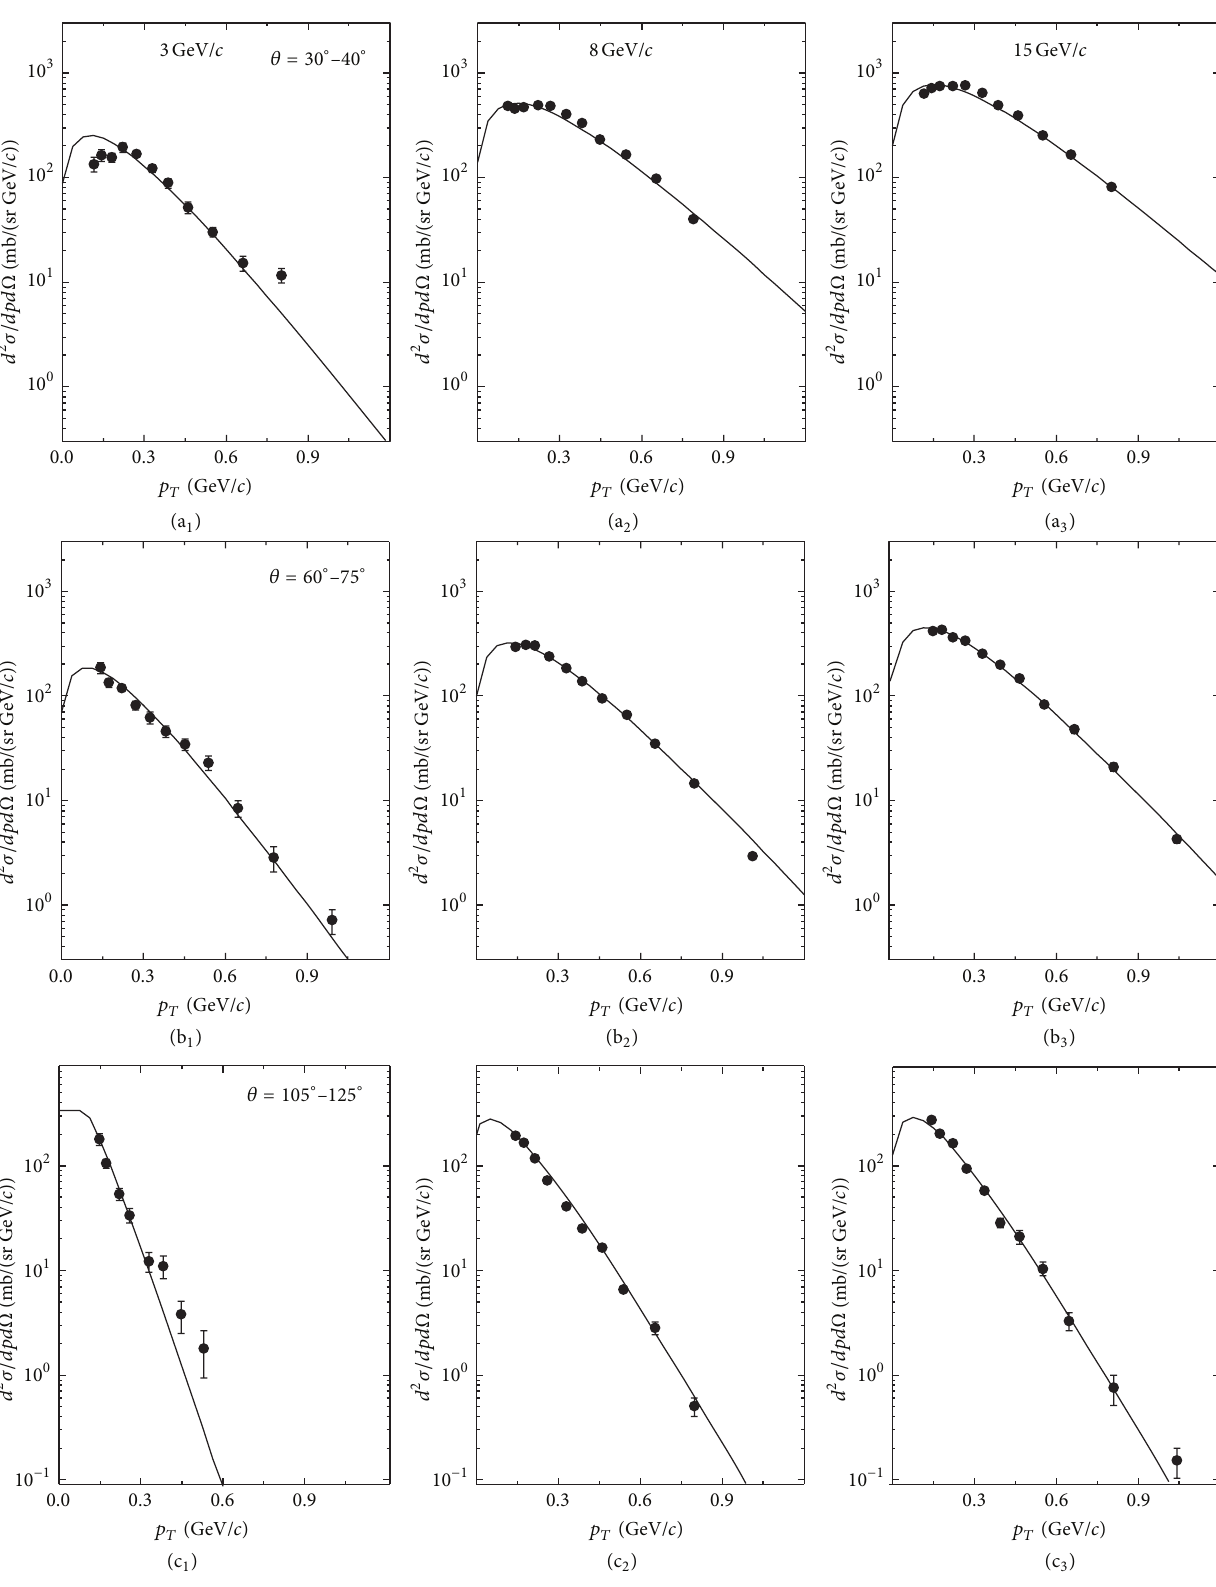
Figure 6: The same as Figure 4, but for 𝜋 +